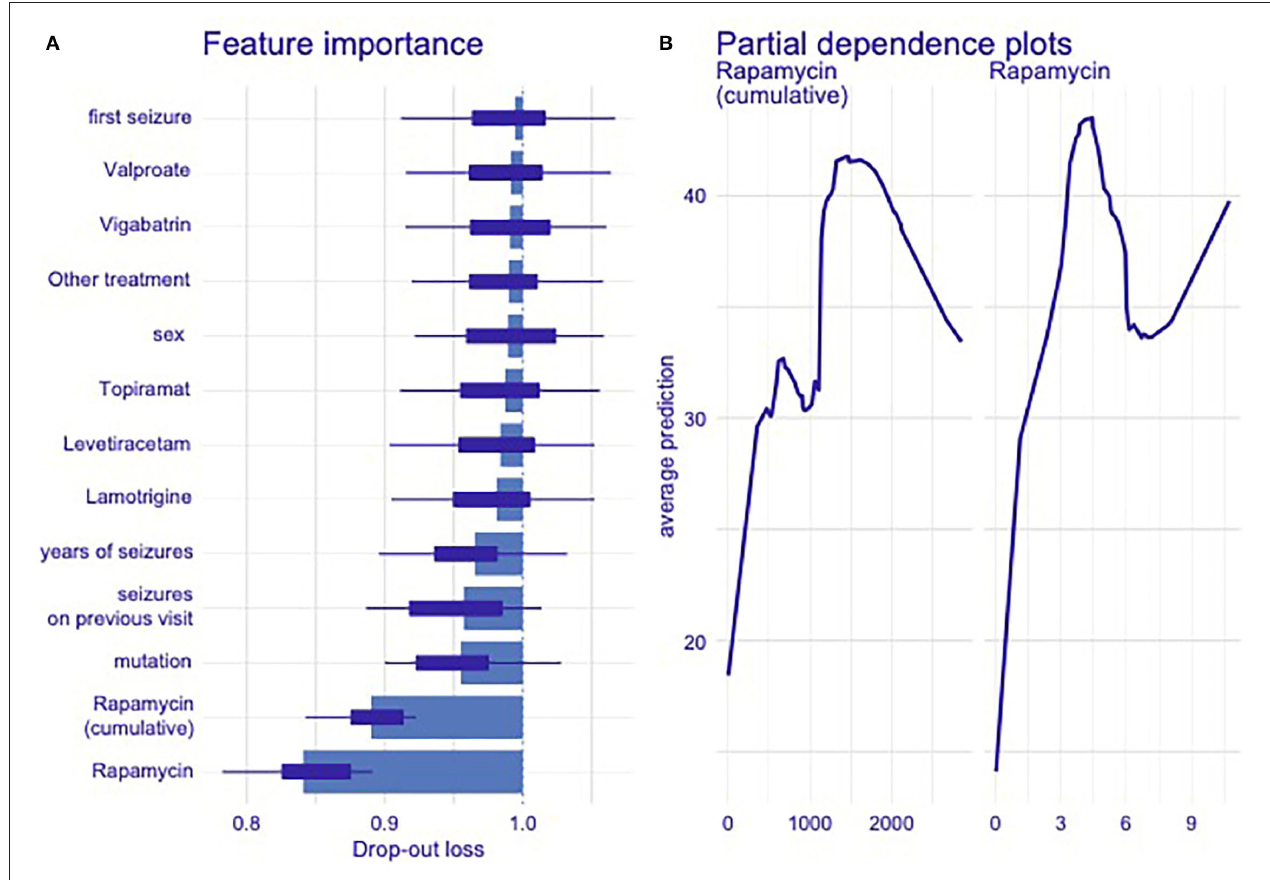
FIGURE 3 | (A,B) Evaluation of the potential influence of additional demographic and pharmacological factors on the efficacy of rapamycin therapy (A) and evaluation of the optimal cumulative dose (the total dose of rapamycin taken over the course of treatment) of rapamycin in the studied group of patients (B) resulting from mathematical modeling. Only variables related to rapamycin dosage were consistently and clearly associated with the model performance. Detected feature importance from autoML model (A) and partial-dependence plots (B) showed non-linear relationship between therapeutic concentration of rapamycin and total cumulative dose of the drug taken during given period of therapy. The ratio of seizure reduction within these dependencies, expressed as average prediction. We used the DALEX package ( 30) to find relationship between individual variables in ML model and predicted outcome. First, we used it to calculate feature importance. In plot 3 (“feature importance”), one can see average drop in classifier accuracy when variable was permuted (scrambled). Higher loss meant higher importance. Then, we calculated partial dependence plots for two most important variables (rapamycin dosage on previous visit and cumulative rapamycin dosage), plots on the right hand side showed the average prediction of ML model given different levels of those